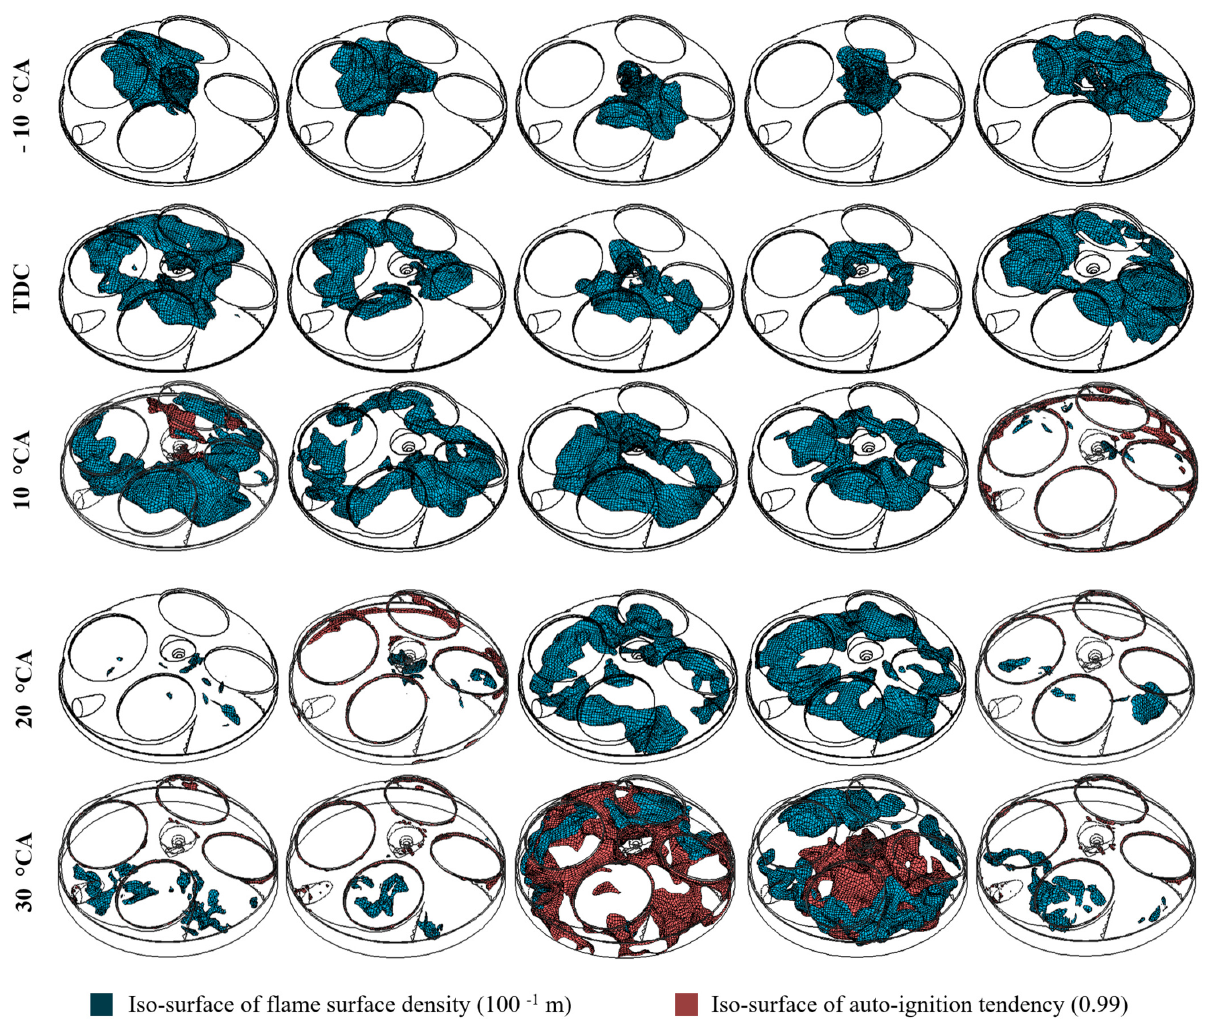
Figure 13. Iso-surface of the flame front and auto-ignition